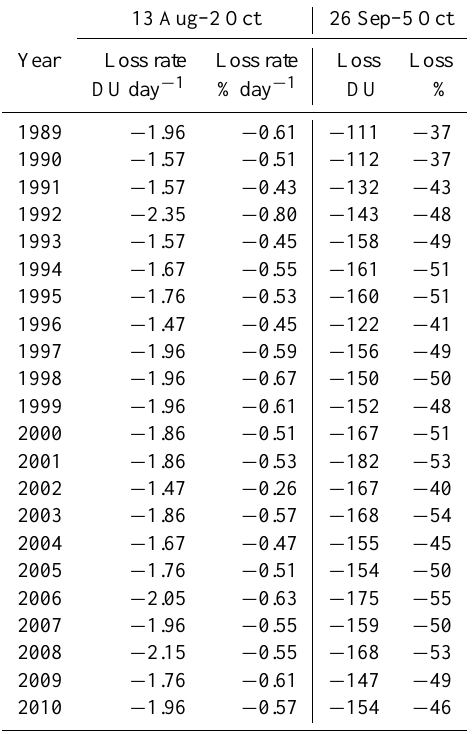
Table 2. The cumulative ozone (O 3 ) loss estimated from 1 June averaged between 26 September and 5 October. The loss is com- puted as the ground-based O 3 − passive O 3 tracer in DU and 100 × (ground-based O 3 − passive O 3 tracer)/passive O 3 tracer in %. The instantaneous ozone loss rates estimated between 13 Au- gust and 2 October (dates in the year covered by all measurement stations) from ground-based measurements in the Antarctic are also shown. The loss rates are given in DUday − 1 and %day − 1 . The uncertainty of the estimated O 3 loss is about 3–5%.